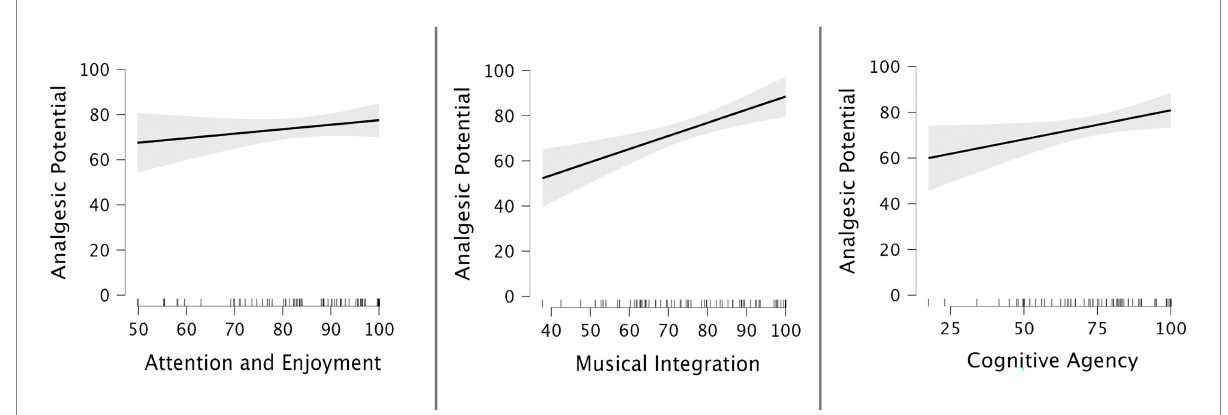
FIGURE 2 Regression plots of marginal effects. This diagram shows the individual marginal effects of each factor included in the linear regression model Attention and Enjoyment, Musical Integration, and Cognitive Agency. The y -axis indicates the analgesic potential scale from 0 to 100. The steeper slope for Musical Integration and Cognitive Agency illustrates that participants consider it to be more important when they are choosing their music than Attention and